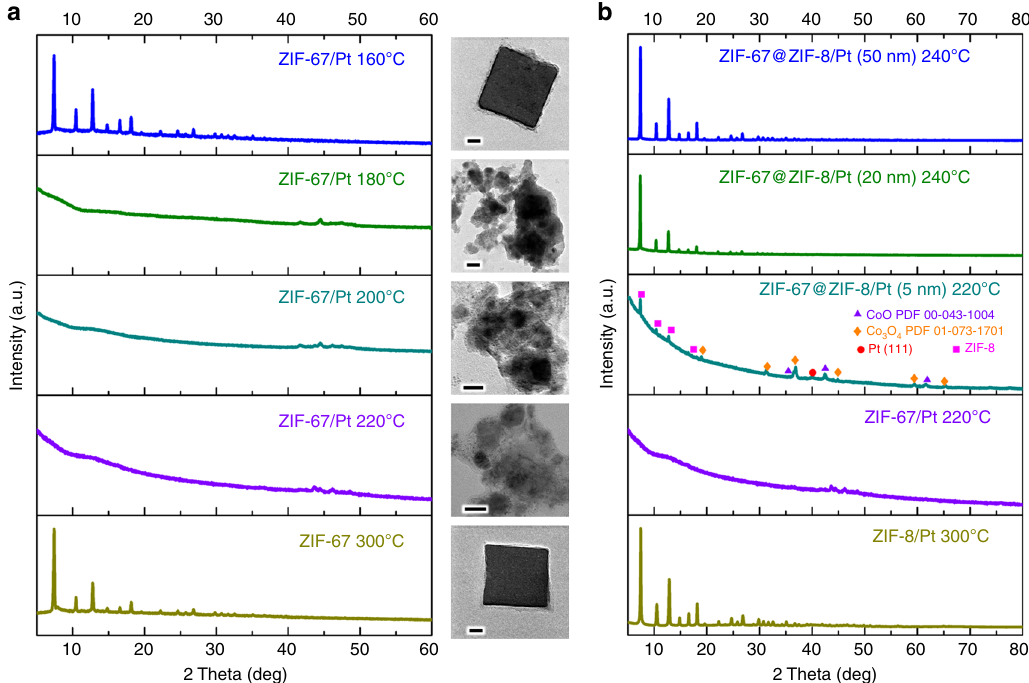
Fig. 6 Characterizations of ZIF nanocomposites after soaking in H 2 at different temperatures. a XRD patterns and the corresponding TEM images of various ZIF-67 and ZIF-67/Pt after soaking with fl owing H 2 (4 h), and b XRD patterns of ZIF-8/Pt, ZIF-67/Pt and ZIF-67@ZIF-8/Pt nanocomposites with various thickness of ZIF-8 layer under fl owing H 2 (4 h). The structural con fi gurations of the above samples can be referred to Fig. 5 and Supplementary Fig. 27. Scale bars in the inset TEM images from top to bottom are 30, 40, 20, 30 and 30 nm,